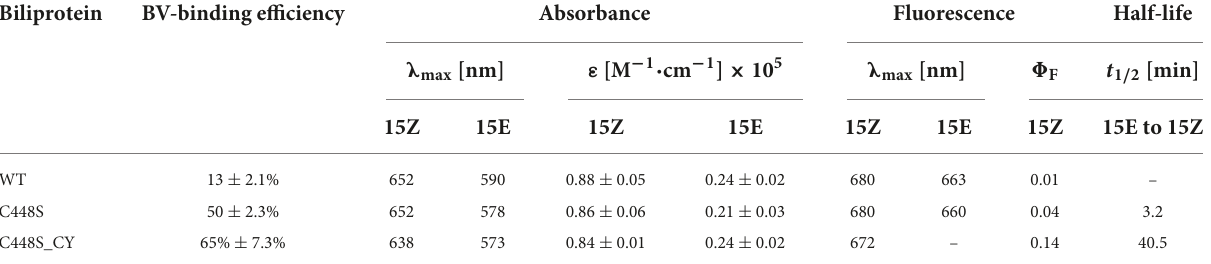
TABLE 1 Biochemical properties of BV-binding SPI1085g3 (WT) and its variants.